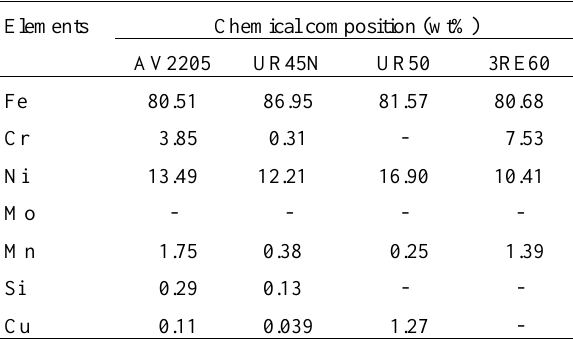
Table 9. The chemical composition of the new austenite for alloys heat-treated at 850 °C for 1 h.